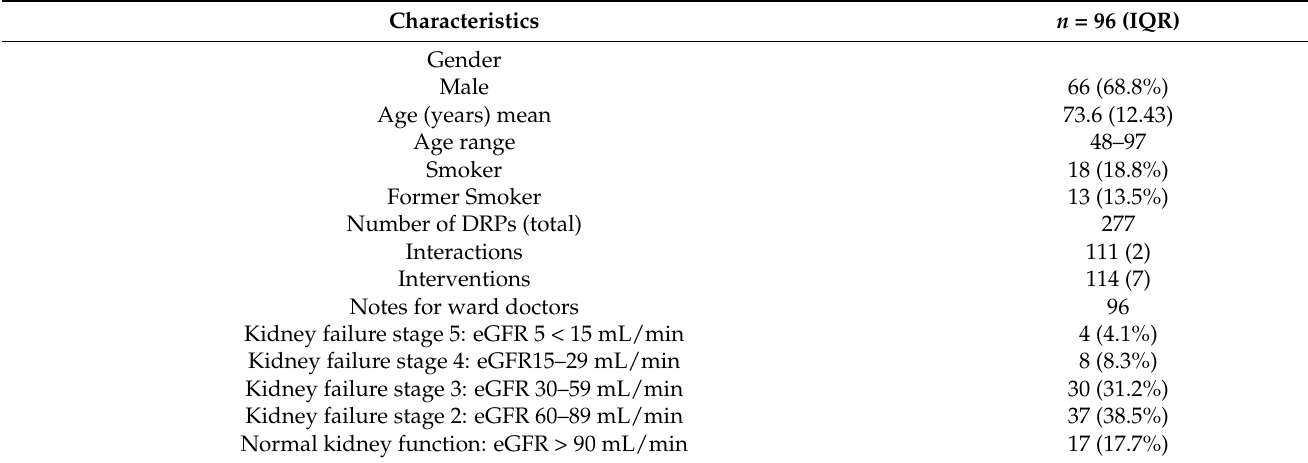
Table 1. Patient characteristics, median (IQR), or n